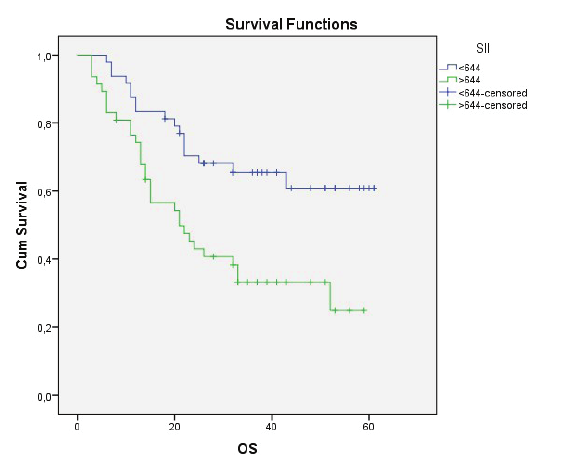
Figure 3a - Kaplan-meier curve for overall survival of low and high systemic immune-inflammatory index group